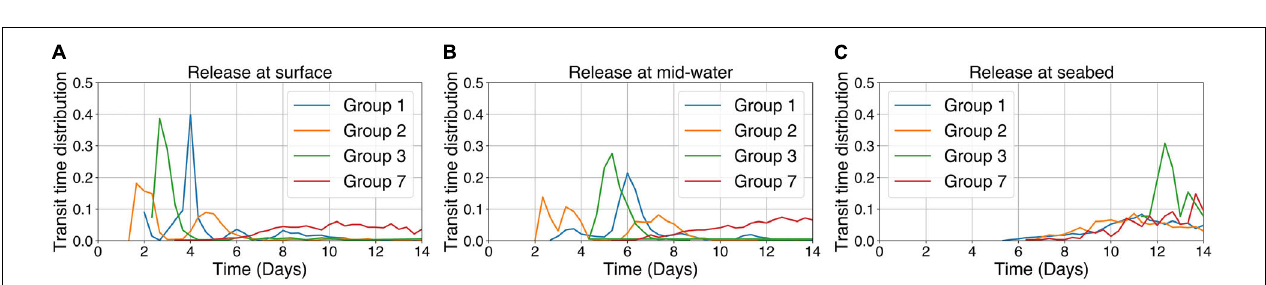
FIGURE 7 | Transit time distribution for connections between the occupied grid cells in each of the Groups passing over or terminating in another occupied grid cell in another Group for particles released from the four Groups (1, 2, 3, and 7) using long-term averaged currents showing connectivity ( Figures 4A,B ) with k h = 250 m 2 s − 1 . (A) Particles released from the surface; (B) Particles released from mid-water depths; and (C) Particles released from the seabed.